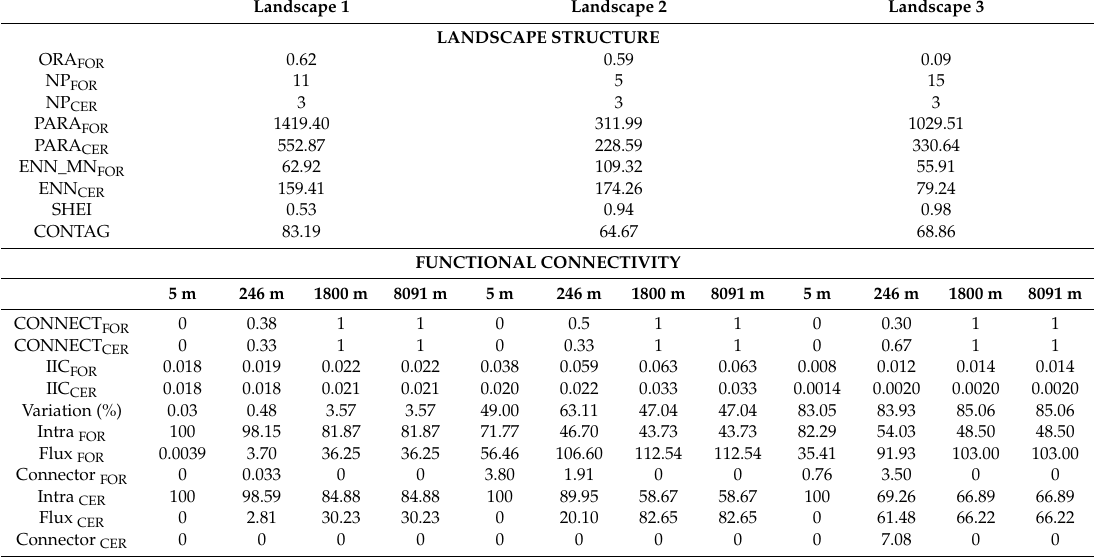
Table A1. Metrics results of the three landscapes for all forest cover (FOR) and for cerrad ã o (CER) only. Structural measures of landscapes: Optimal resource availability (ORA), Number of patches (NP), Perimeter / area relationship (PARA), mean Euclidean distance from the nearest neighbor (ENN_MN), Shannon evenness index (SHEI), and Contagion index (CONTAG). Measures of the functional connectivity in the four distance profiles of plant dispersal (short—5 m, medium—246 m, medium–long—1800 m, and long—8091 m): Connectivity index (CONNECT), Integral connectivity index (IIC), variations (%), and contribution of intra, flux, and connector fractions to the general